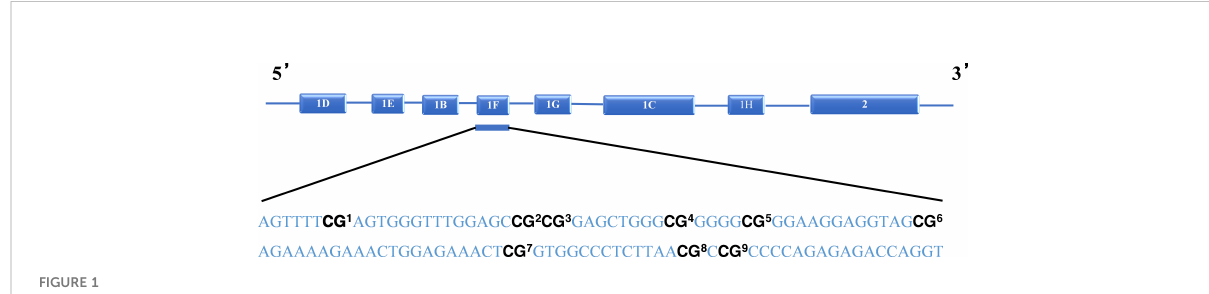
FIGURE 1 Schematic representation of NR3C1 gene and the CpG sites